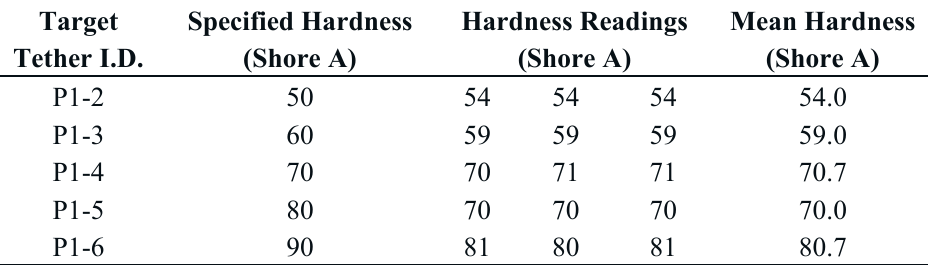
Table 6. Durometer test